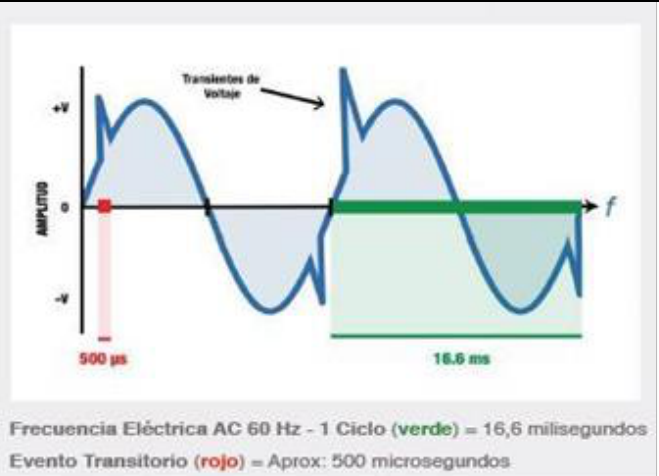
Figura 12: Señal modulada de un Transitorio. Fuente: Los Autores, (2018).